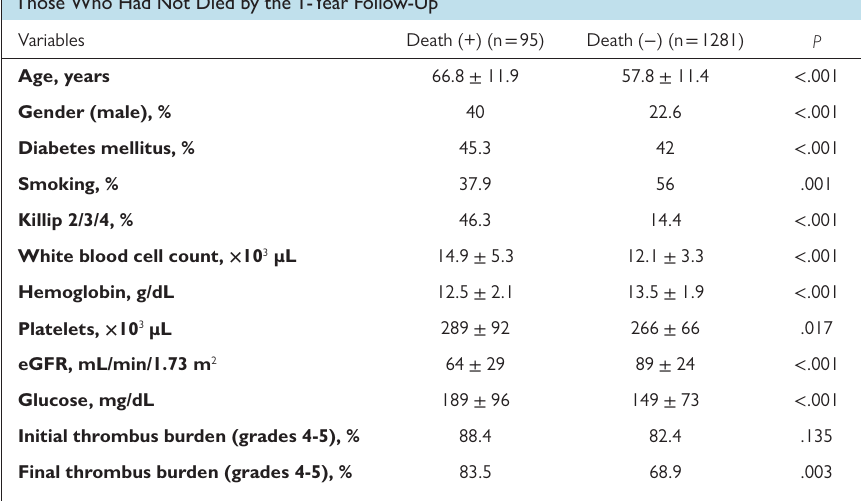
Table 5. Comparison of Clinical and Angiographic Features Between Patients Who Had Died and Those Who Had Not Died by the 1-Year Follow-Up